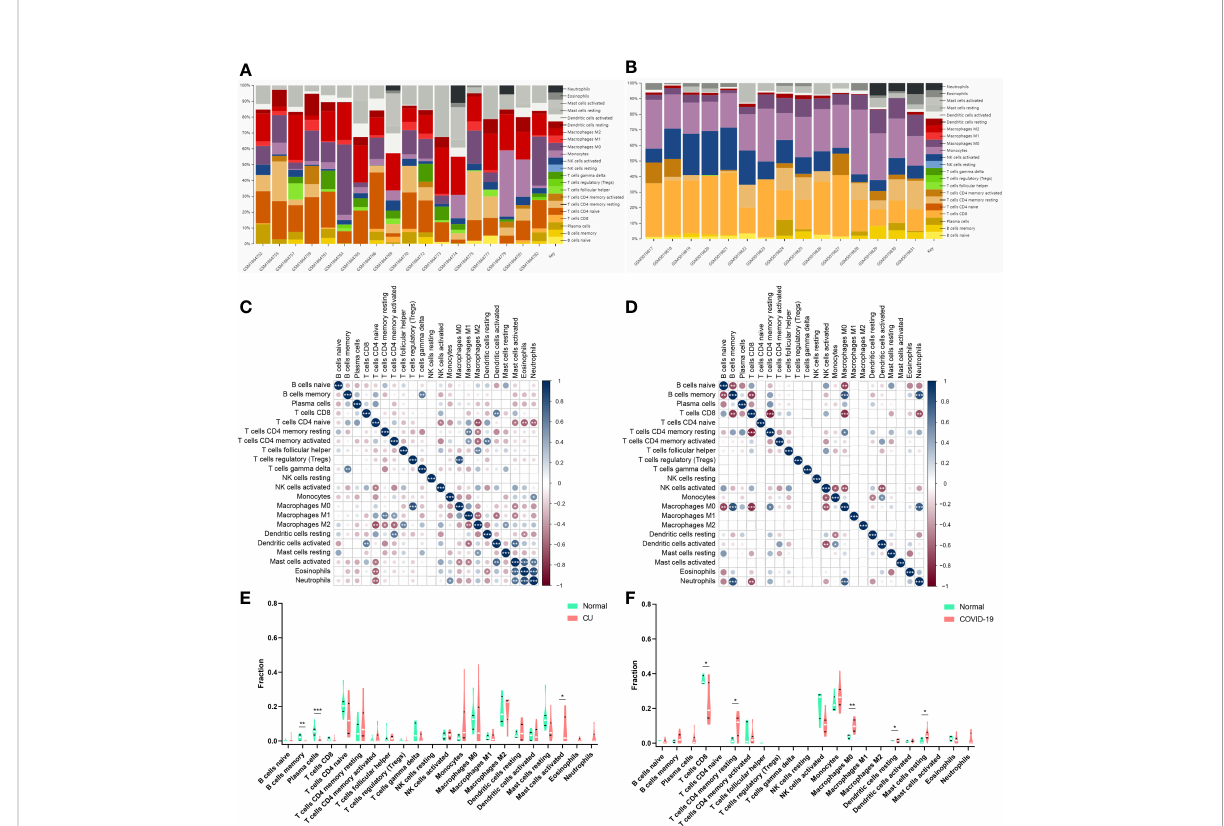
FIGURE 8 Immune in fi ltration analysis. (A) The ratio of 22 immune cells in CU samples. (B) The ratio of 22 immune cells in COVID-19 samples. (C) The association among immune cells of CU. (D) The association among immune cells of COVID-19. (E) The proportion of immune cells in CU and control. (F) The proportion of immune cells in COVID-19 and control. *p < 0.05; **p < 0.01; ***p < 0.001.